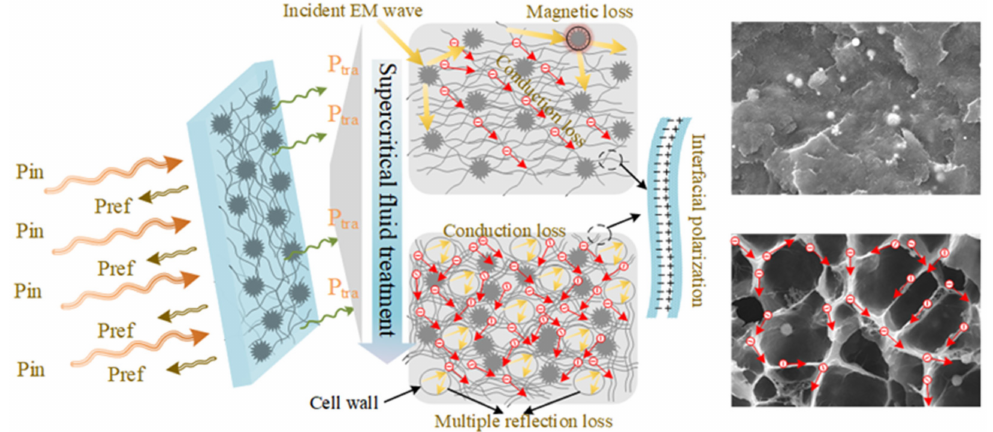
Figure 8. The schematic diagram of the microwave shielding mechanism in the solid and foamed PVDF/CNTs/urchin-like